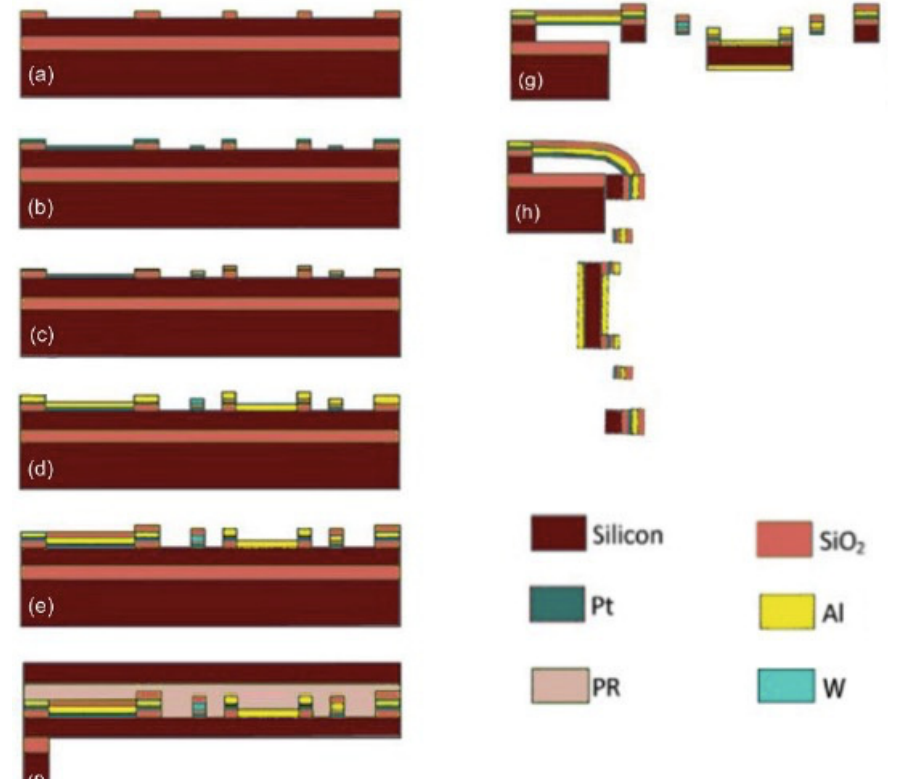
Figure 8. MEMS fabrication processing. (a) Mirror frame deposit. (b) Pt heating sputtering. (c) W layer sputtering. (d) Connection layer sputtering. (e) Protecting and pad layer deposit. (f) Backside etching. (g) MEMS structure etching. (h) Final release.